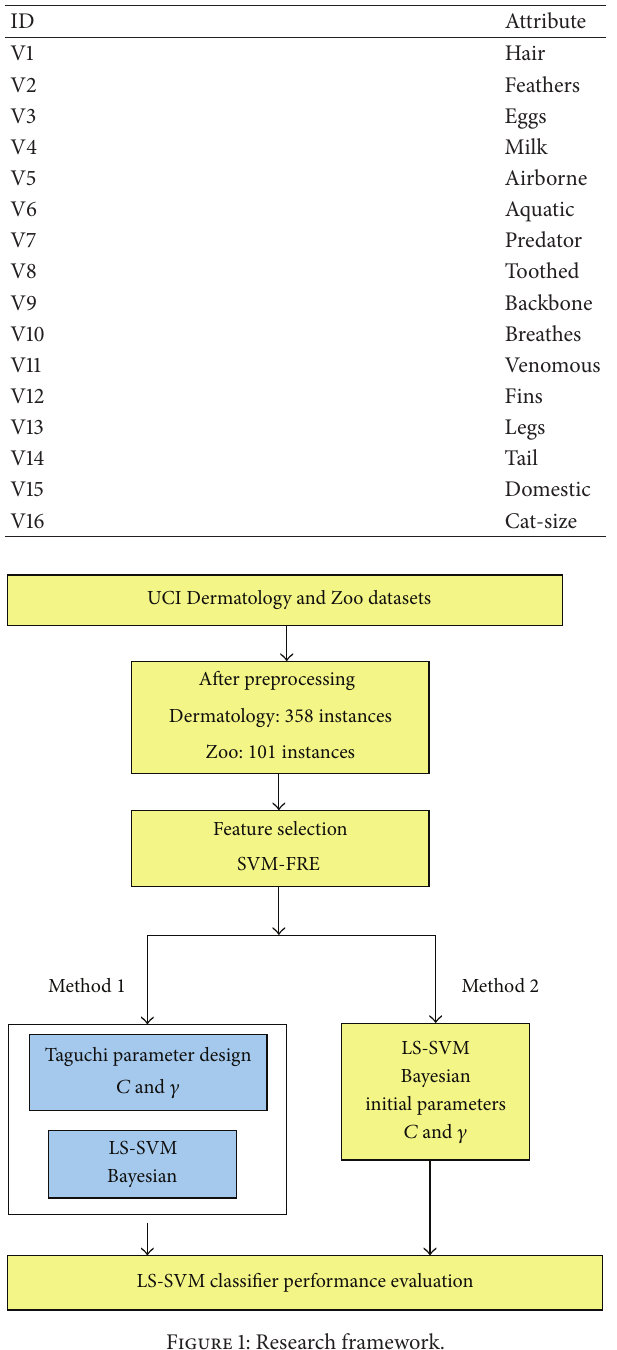
Table 3: Attributes of Zoo database.